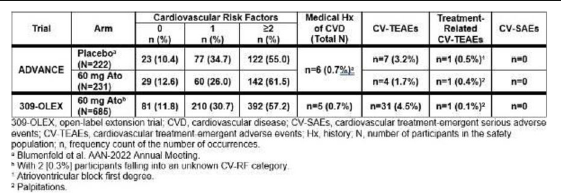
Table 1 (abstract 106). See text for